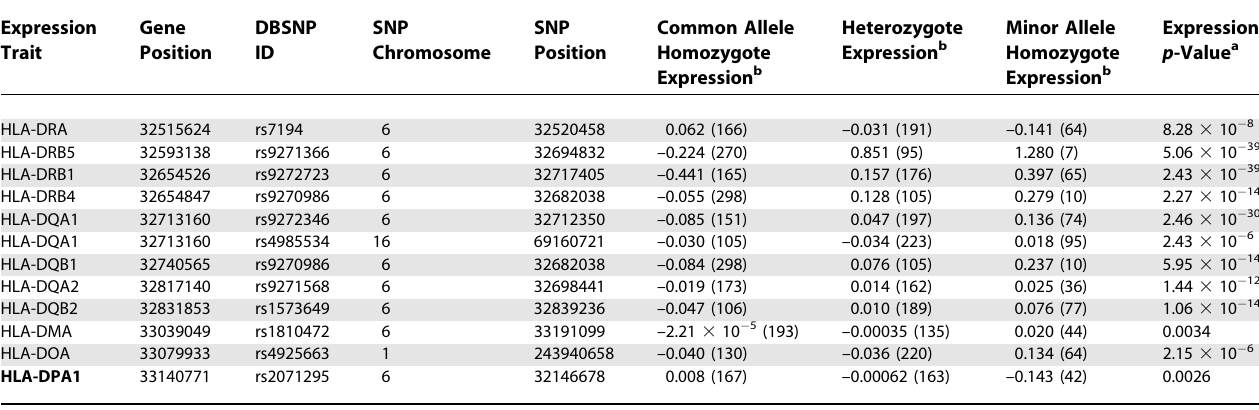
Table 2. Significant Associations Detected in the HLC for 11 of the 14 HLA Class II Gene Expression Traits Represented on the Microarray Used in This